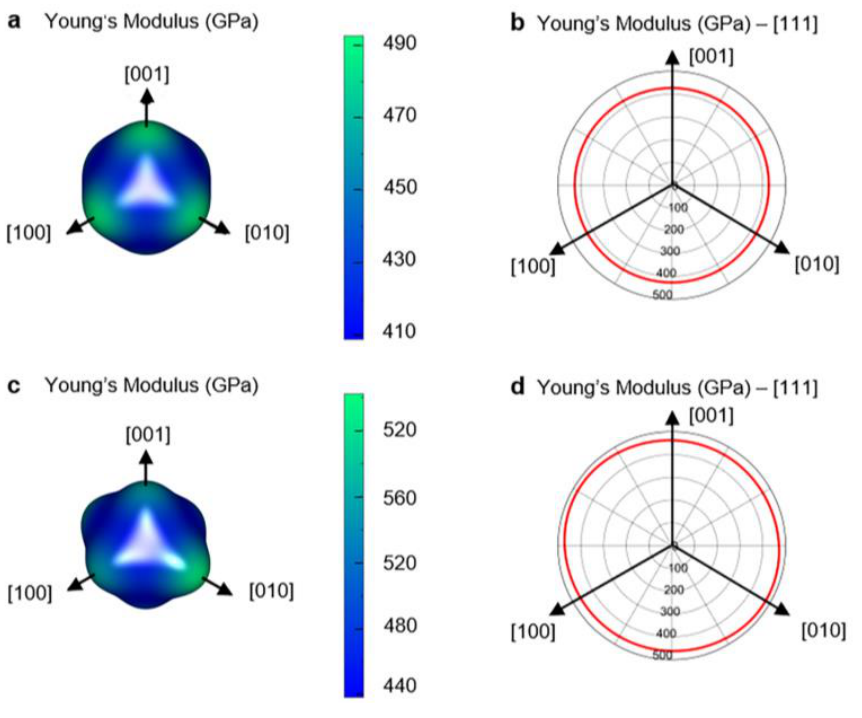
Figure 6. The direction-dependent Young’s modulus and its planar projections on [111]. ( a , b ) HfC, and ( c , d ) Hf 0.5 Ta 0.5 C.